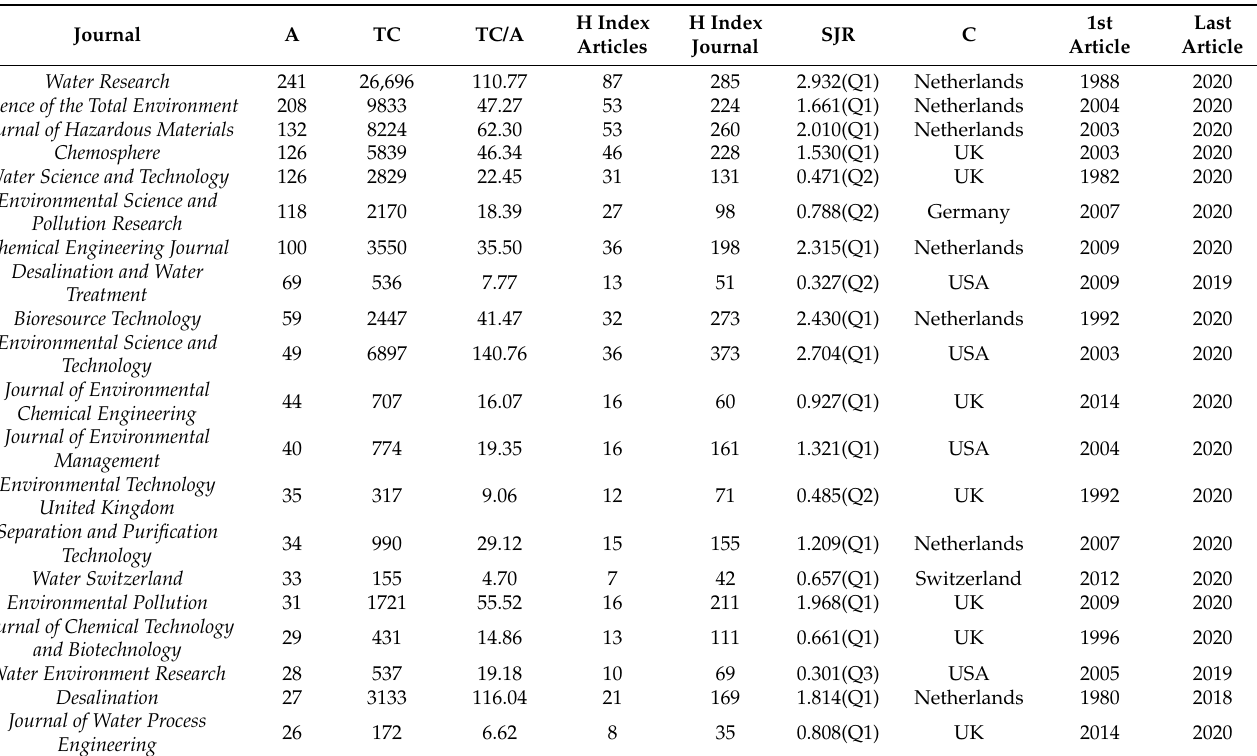
Table 4. Most active journals on RPW from 1979 to